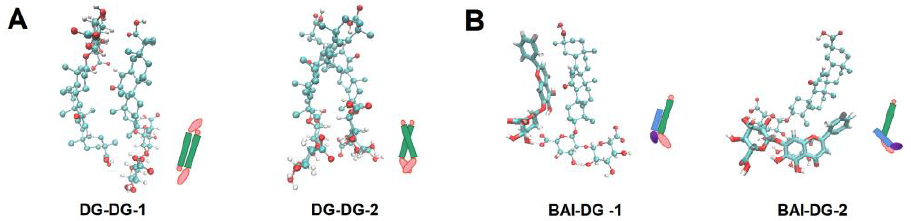
Figure 5. Molecular binding conformations of DG-DG ( A ) and BAI-DG ( B ). Table 2. Analysis of intermolecular interactions.